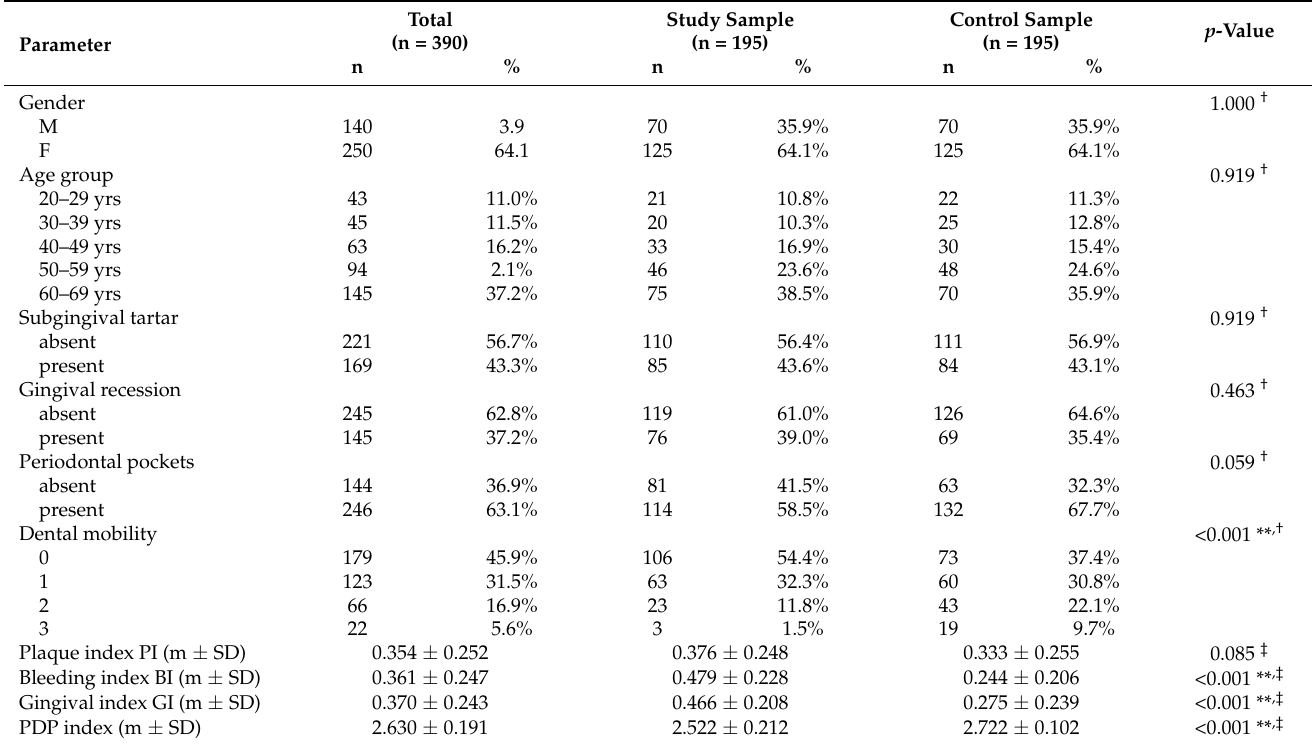
Table 1. Demographic parameters of the